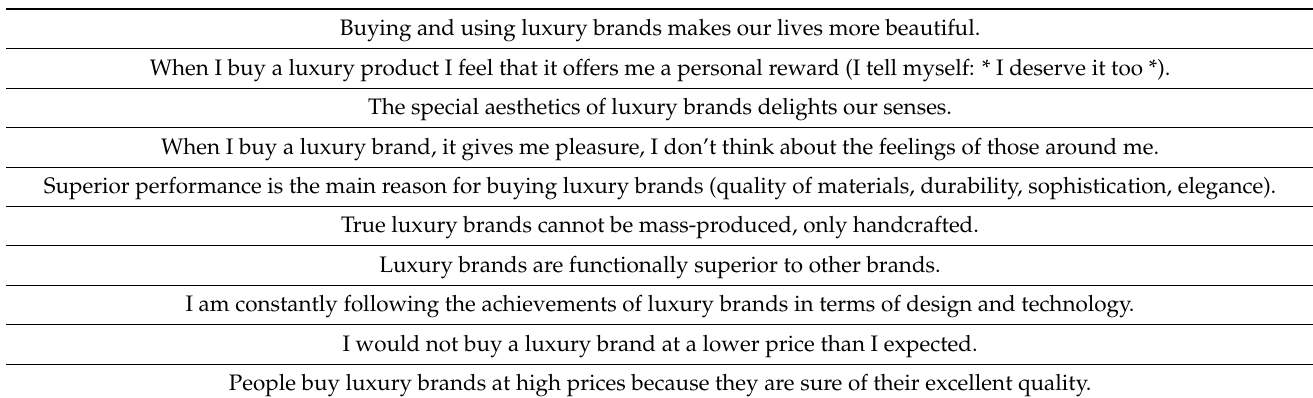
Table A2. The perceived personal value of luxury scale.